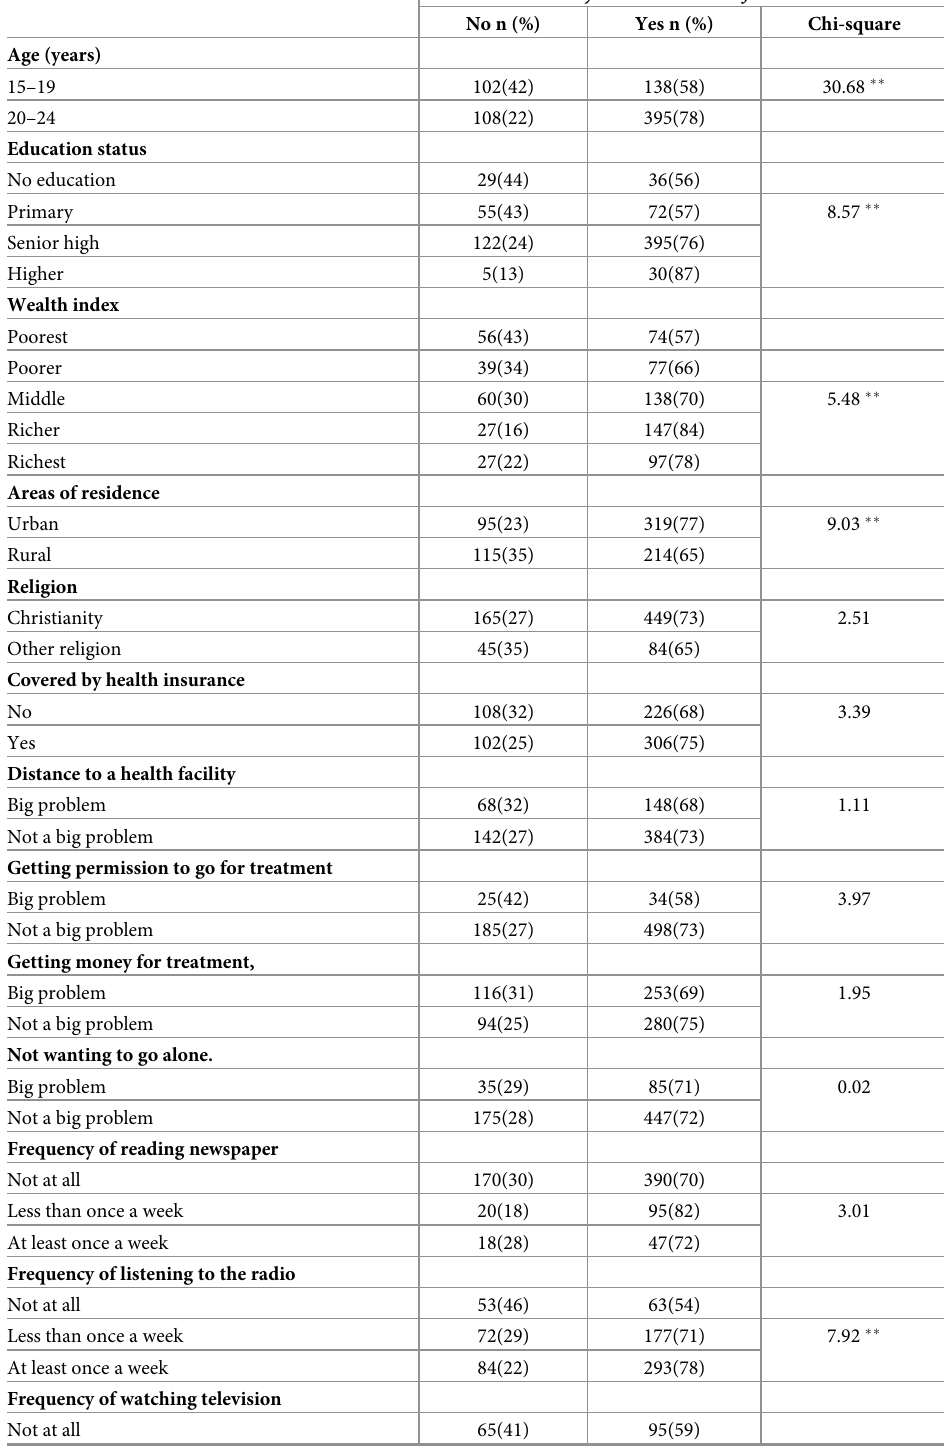
Table 3. Association between participant characteristics and seeking treatment for STIs (n =